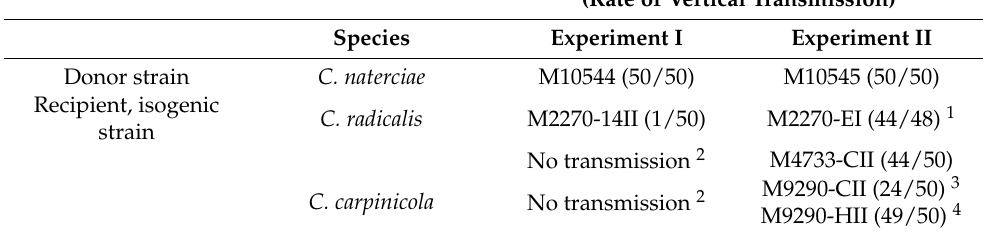
Table 3. Vertical transmission of CnFGV1 in the virus donor strain and in newly infected Cryphonectria species. Listed are, first, donor strains that succeeded in CnFGV1 horizontal transmission and, then, the recipient strains that became CnFGV1-infected. In brackets: rate of vertical transmission of CnFGV1 into conidia spores.